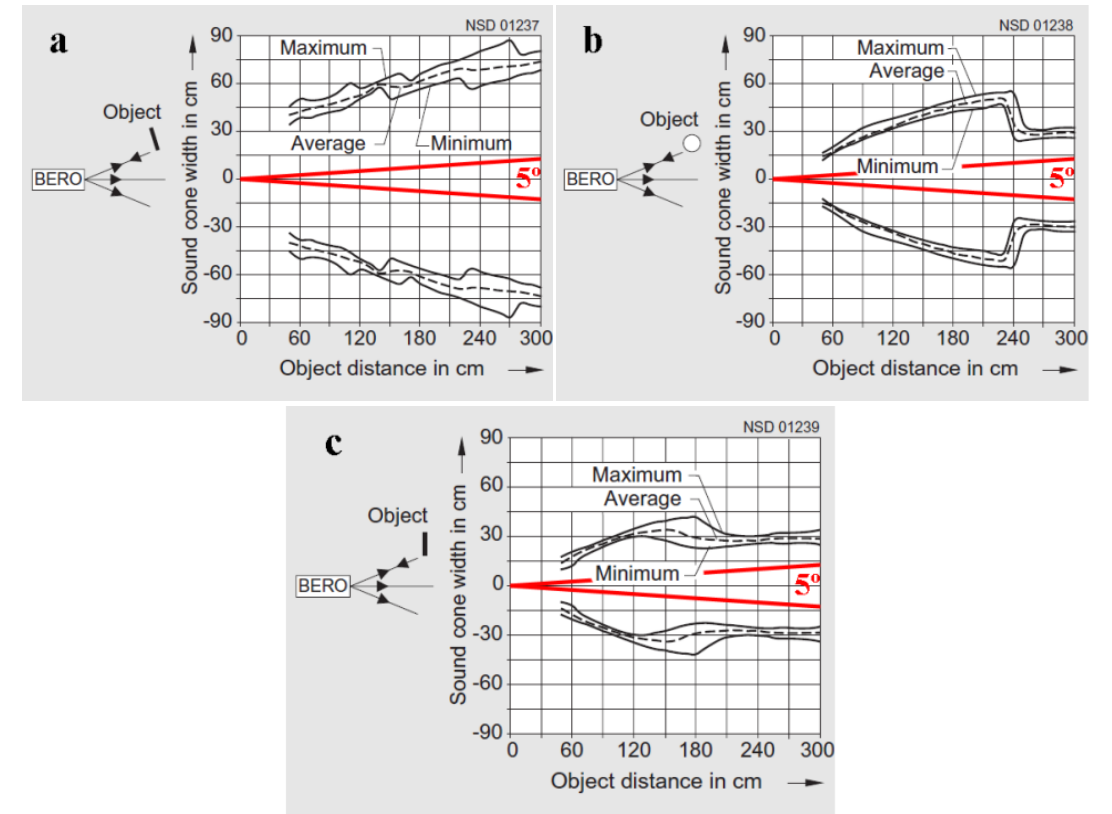
Figure 2. Sound cone diagrams for different types and orientations of targets with a superimposed 5° beam angle cone projection in